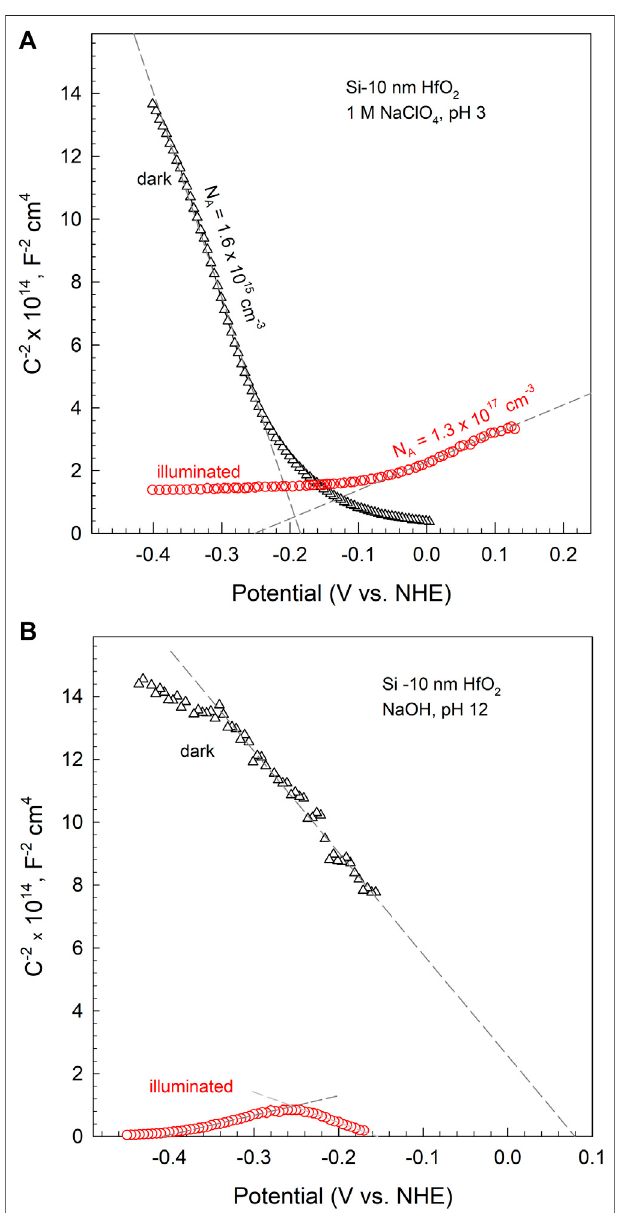
FIGURE 5 | Mott – Schottky plots for p-Si with 10-nm HfO 2 layer in the dark and underillumination( λ =505nm, N =50mWcm − 2 )in (A) 1MNaClO 4 atpH3and (B) NaOHat pH12.Theelectrodepotentialhasbeensteppedfromtheopencircuitinnegativedirection.